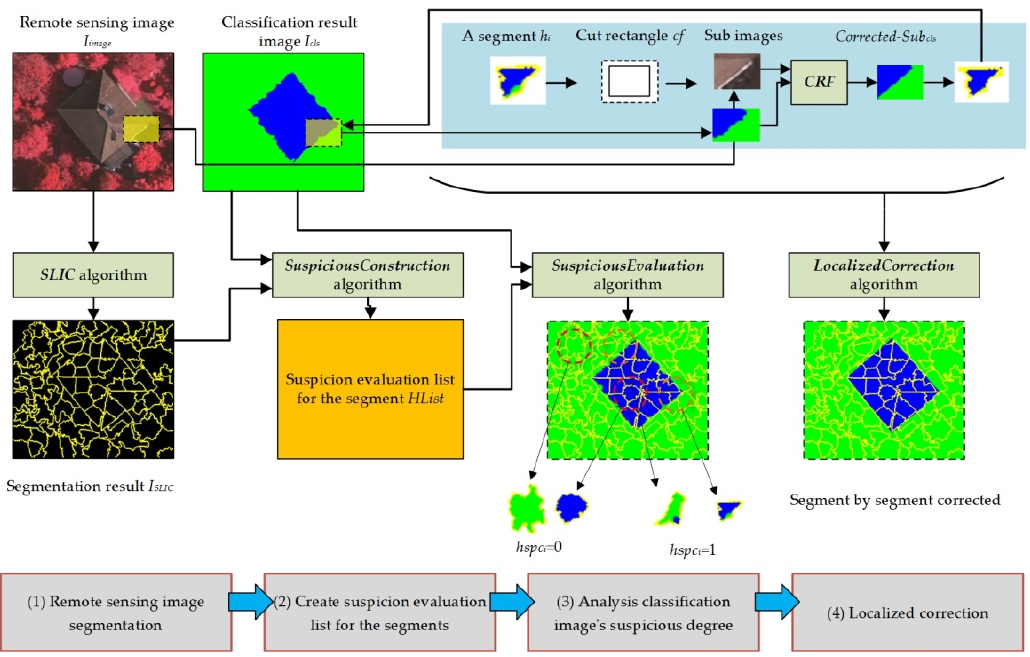
Figure 2. End-to-end result image evaluation and localized Figure 2. End ‐ to ‐ end result image evaluation and localized post ‐ processing.